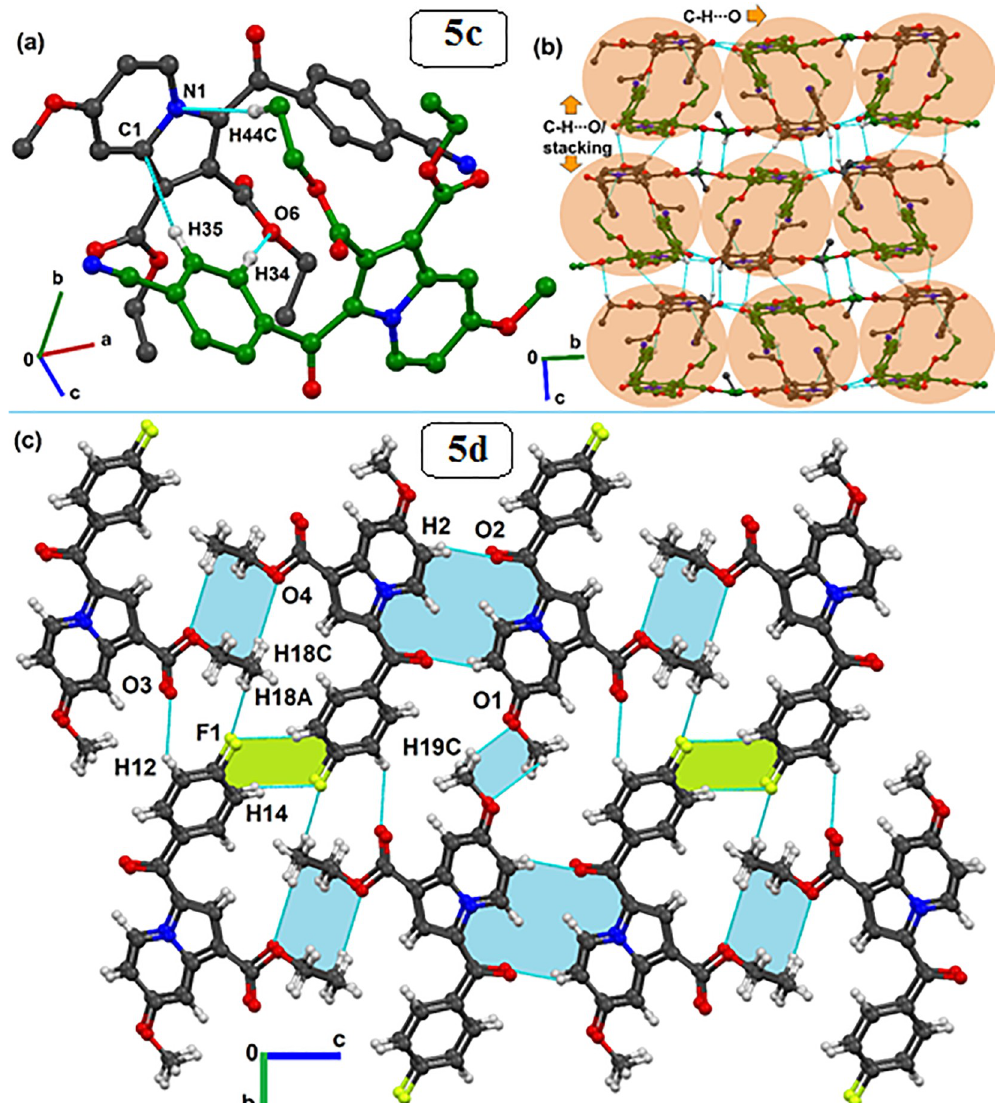
Fig 7. Formation of (a) dimer by two symmetry-independent molecules (black and green) in the asymmetric unit of 5c utilizing C-H ��� O, C-H ��� N and C-H ��� π interactions. (b) Crystal packing for 5c molecules via the association of dimeric motifs (light red) through C-H ��� O and π ��� π stacking interactions. (c) Packing arrangement of 5d molecules stabilized via various strong to weak C-H ��� O (light blue) and C-H ��� F (light green) dimers. Different-colored carbon atoms indicate different symmetry-independent molecules. Non-interacting hydrogen atoms were removed in the case of 5d to clarify the packing